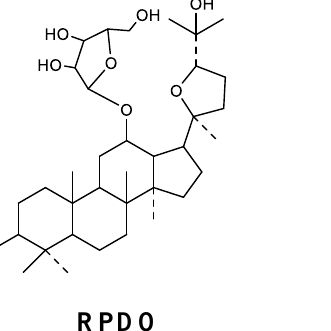
Figure 5. Chemical structures of 12-riboside-pseudoginsengenin DQ (RPDQ) and 20 R -panaxadiol.